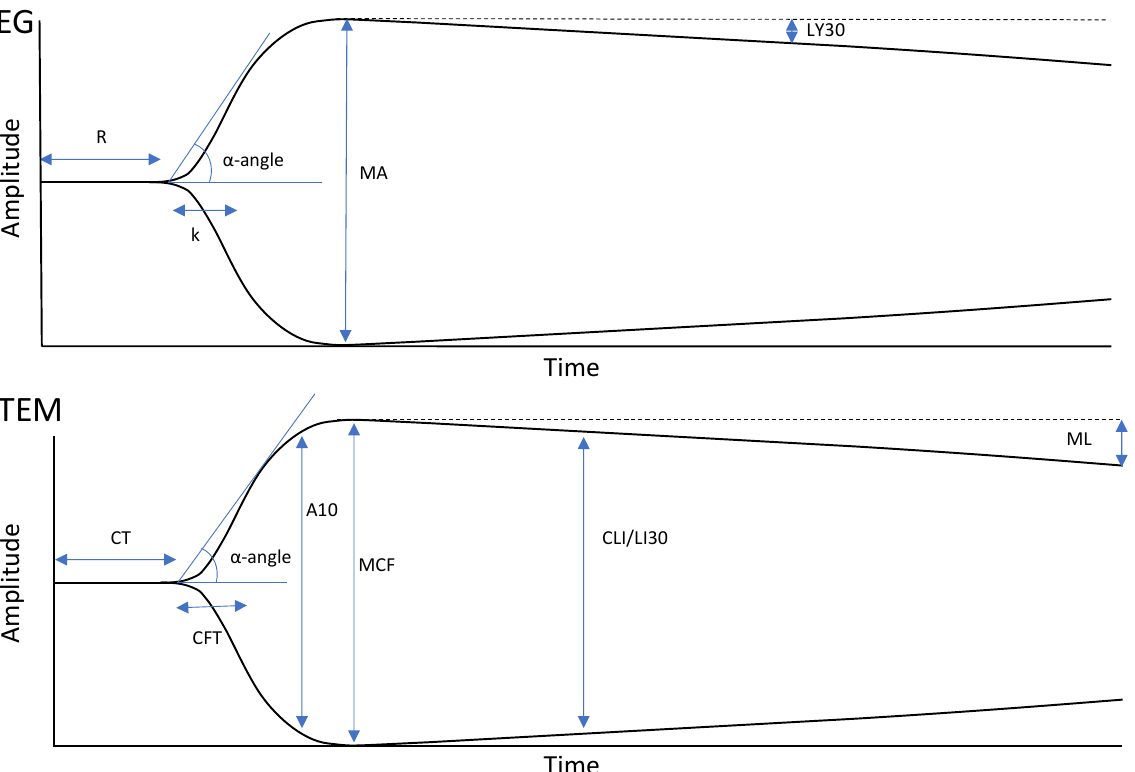
Figure 1. Depictions of normal or physiologic TEG (top) and ROTEM (bottom) tracings. TEG and ROTEM use equivalent but independently labelled parameters. Reaction time (R) and clot time (CT) refer to the time required for the transducer to be displaced 2 mm, correlating with the parameters of the PT/aPTT tests. Clot formation/kinetics (k) and clot formation time (CFT) are measures of initial clot strength and clot formation kinetics, referring to the time required for the transducer to be displaced 20 mm after it reached the 2 mm mark. α -angle is the angle formed between the horizontal axis and the sloped line formed between 0 and 20 mm of amplitude and is used in both TEG and ROTEM technologies. CFT/k and α -angle are broadly correlated with fibrinogen levels. Clot amplitude at 5/10 min (A5/A10) are measurements of the amplitude at 5-min intervals after the CT. Maximum amplitude (MA) and maximum clot firmness (MCF) refer to the maximum displacement acquired and are measures of maximum clot strength. They correlate with maximum clot retraction as a reflection of the crosslinking of fibrin with platelets. TEG and ROTEM analyzers also use differing parameters to describe fibrinolysis. Lysis at 30 min (LY30) shows the percent decrease in amplitude 30 min after achieving MA. Clot lysis index at 30 min (CLI30) is the residual clot remaining 30 min after CT, measured as a percentage of MCF. Maximum lysis (ML) is a measure of the percent decrease in amplitude at the end of the run. Adapted from [23] with permission from Semin Thromb Hemost.,